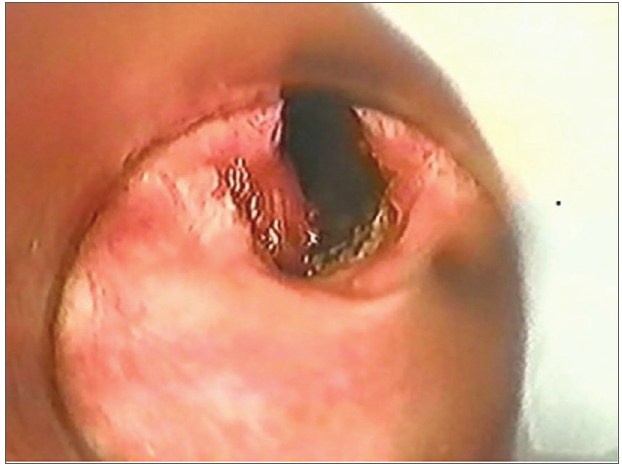
Figure 2. Unilateral microtrapdoor flap: posterior glottic stenosis grade III.